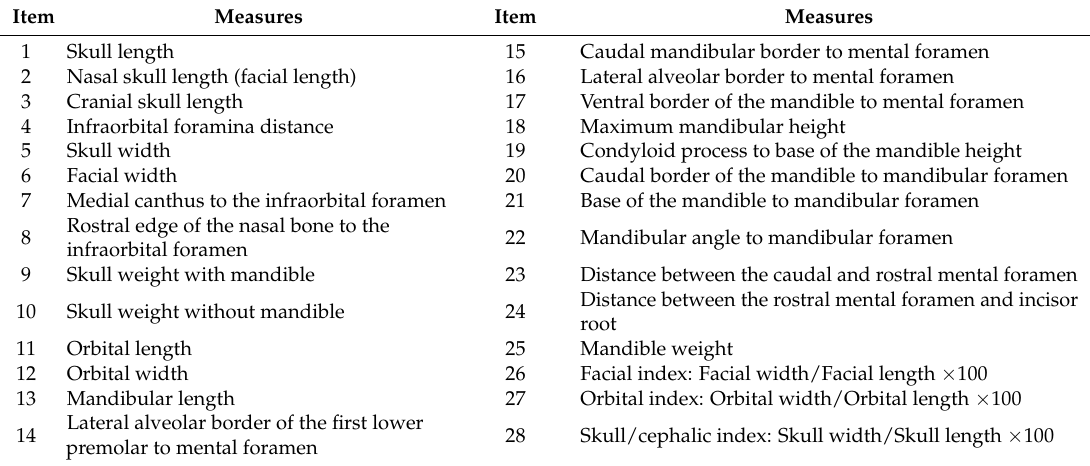
Table 1. Anatomical measurements of the skull and mandible of the common